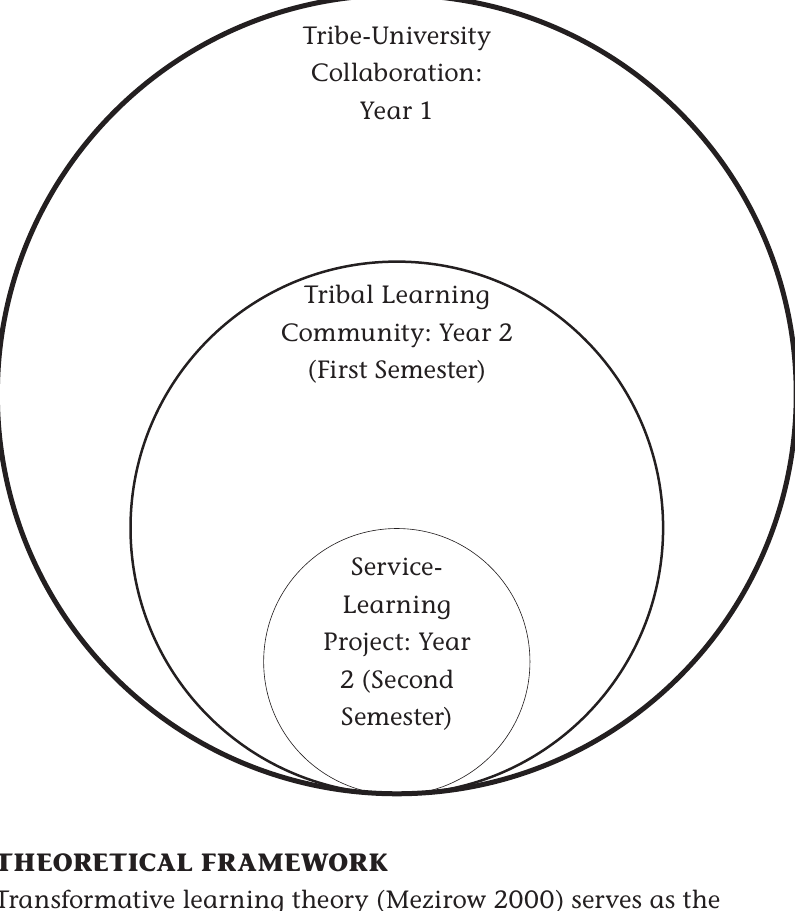
Figure 1: Structure of